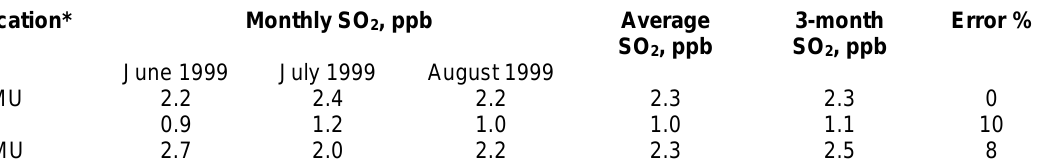
PASS SO Results Comparison of Three Successive Monthly Exposures and Exposures 2